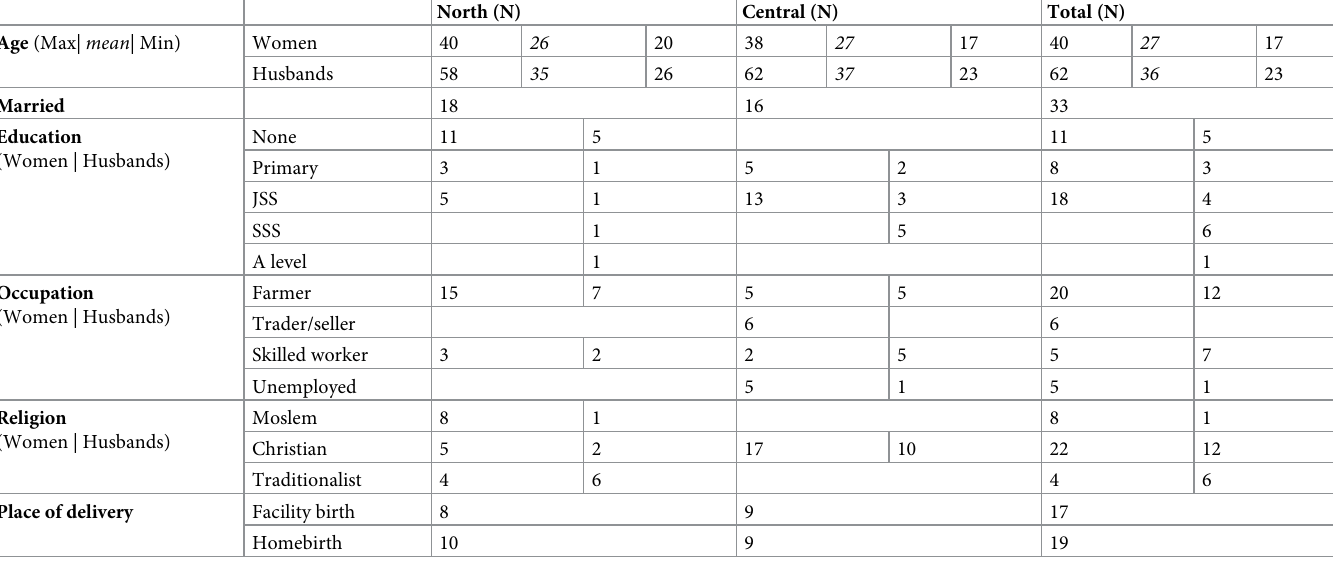
Table 2. Demographic characteristics of women and husbands.